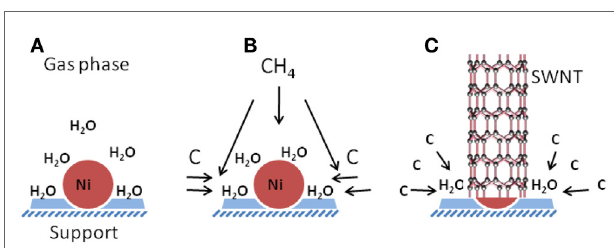
FigUre 6 | a schematic shows the kinetic growth process of sWcnTs and the associated role of water played as the intermediate between gas phase carbon and nickel catalyst to etch amorphous carbon away . Schematic (a–c) corresponds to the initial state of the catalyst without any carbon feedstock, the introduction of methane gas in the CVD system, and the growth stage of SWCNTs,